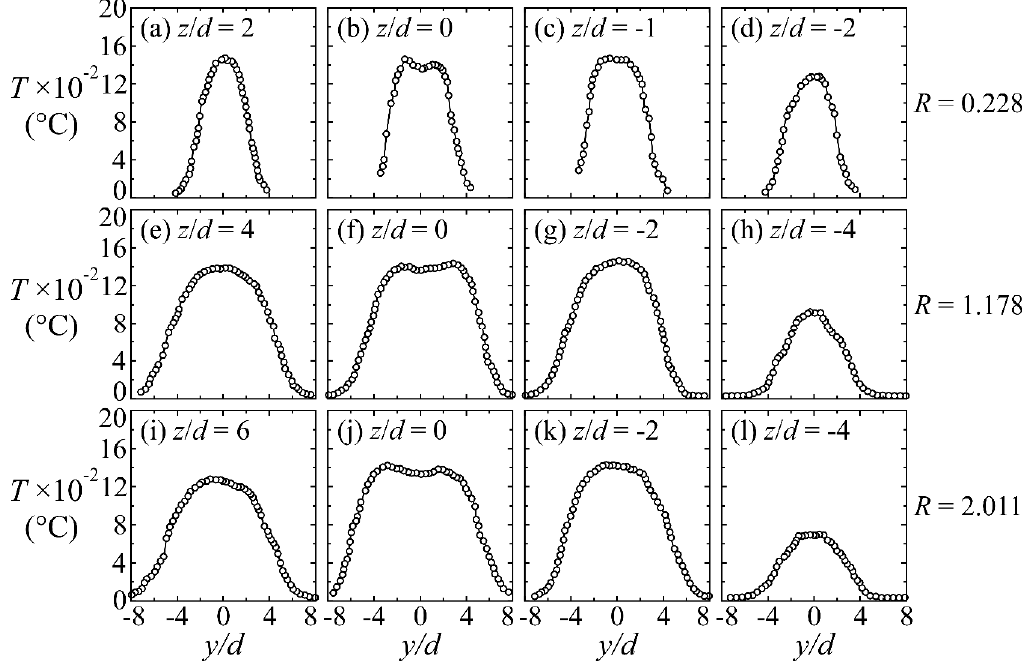
Figure 13. Time-averaged temperature distributions. R = 0.228, 1.178, and 2.011. θ = 15°.